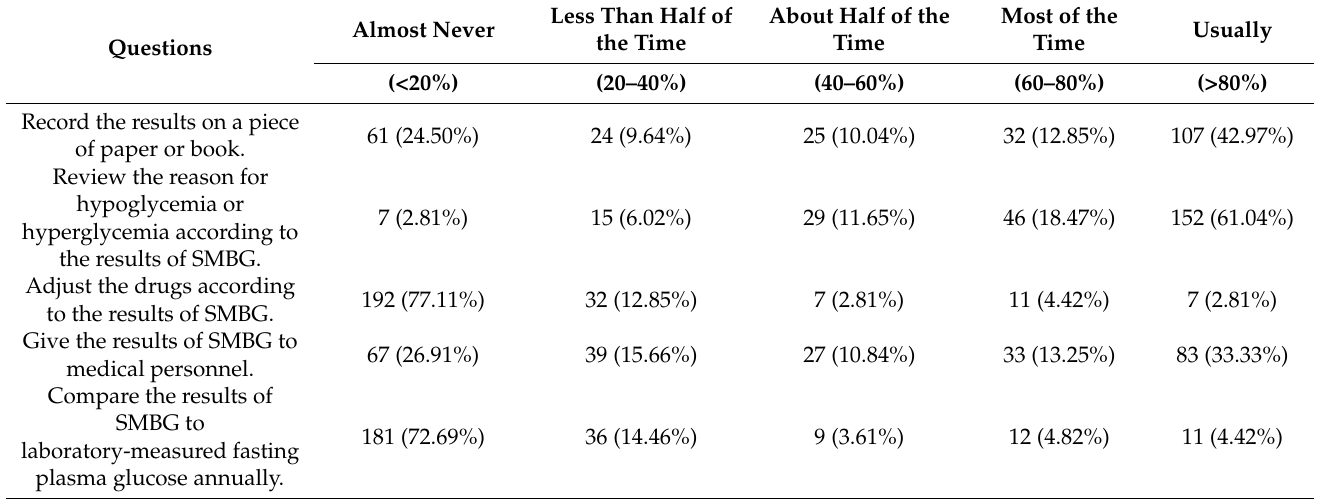
Table 3. Behavior of SMBG restricted to patients who checked SMBG in the past 1 month ( n =